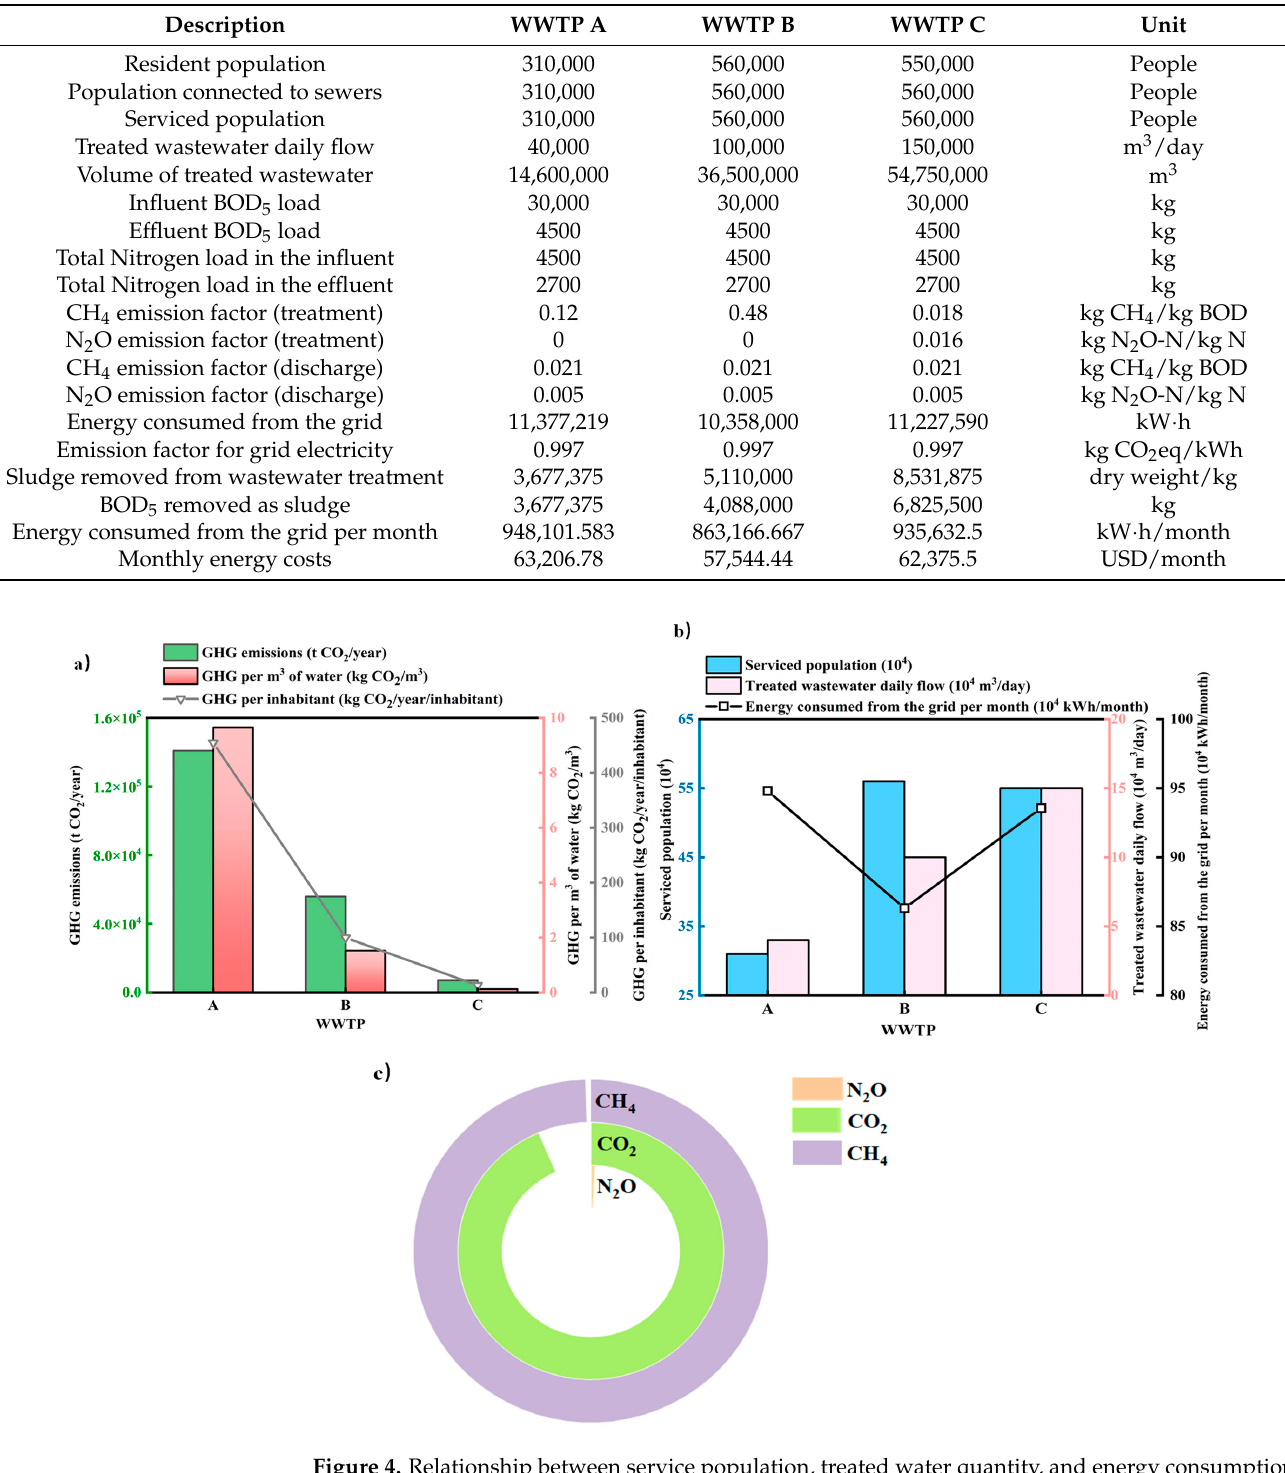
Table 4. Digital data to the rapid assessment stage of the ECAM tool—WWTP in Kunming.